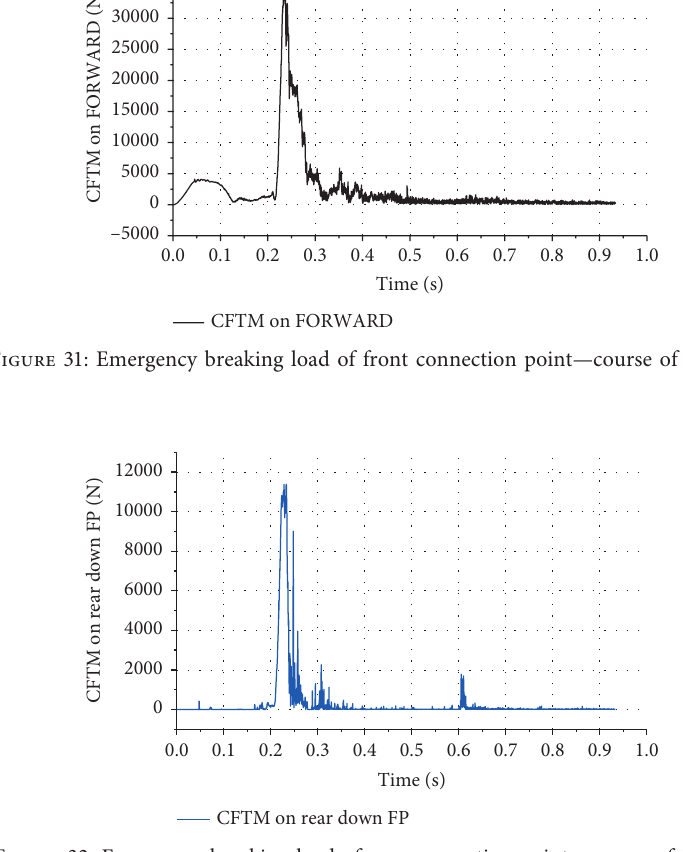
Figure 32: Emergency breaking load of rear connection point—course of